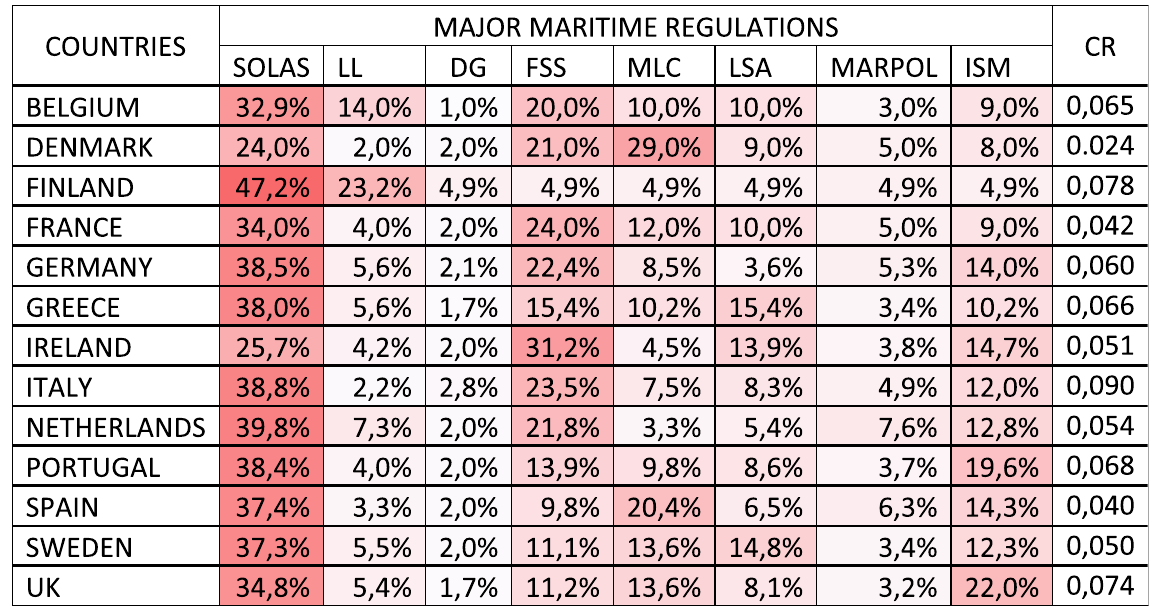
Table 7 Result of AHP for EU15 countries of major Maritime regulations